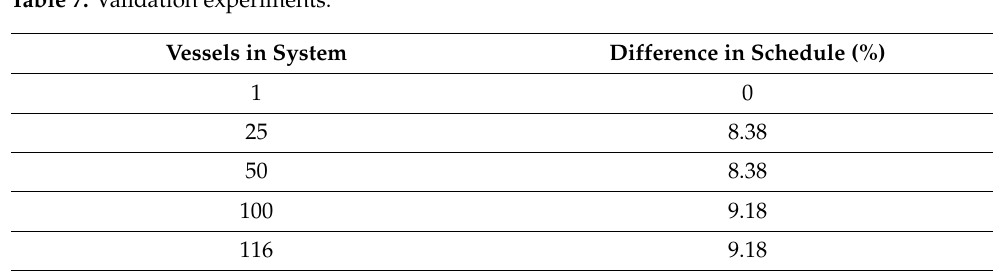
Table 7. Validation